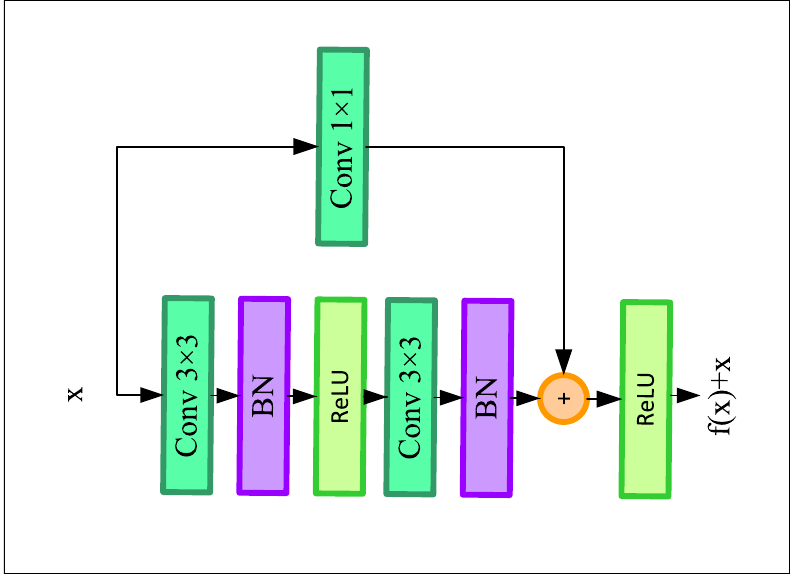
Figure 2. Structure of the residual